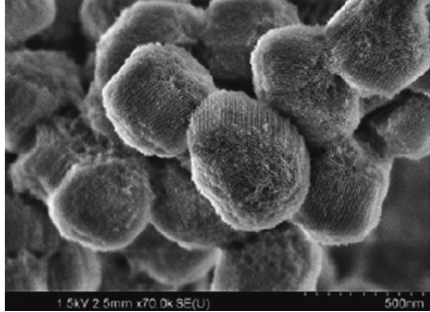
Figure 6: SEM image of the platelet-like SBA-15 mesoporous silica resulting from the use of decane. Reprinted with permission from [61]. Copyright (2011) American Chemical